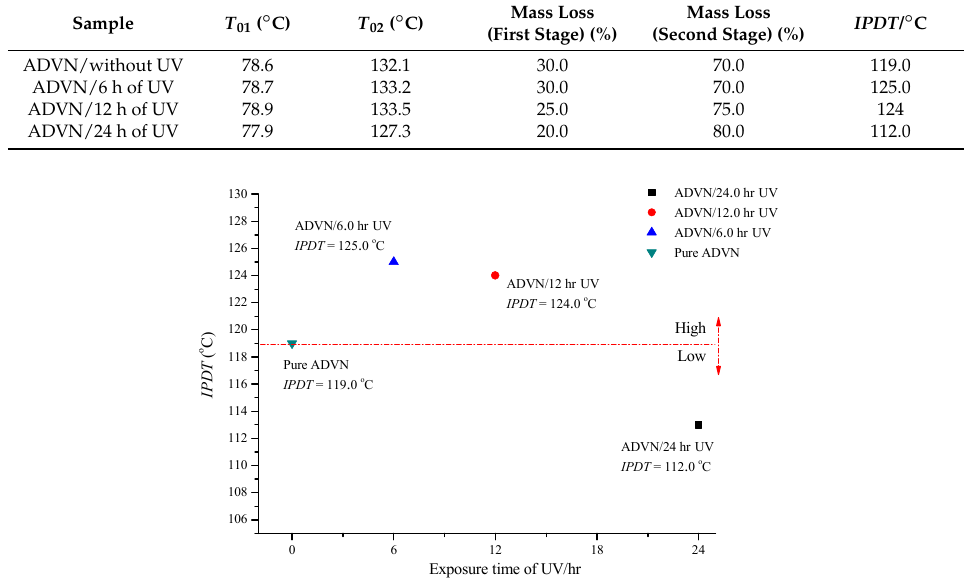
Table 1. Thermal stability parameters by TG testing for ADVN and ADVN exposed to 6, 12 and 24 h of UV at a heating rate 20 °C.